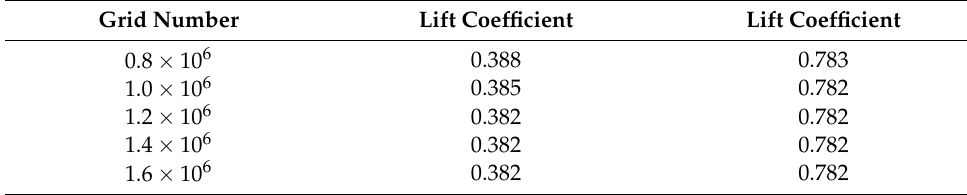
Table 1. Grid independence verification of TTR.